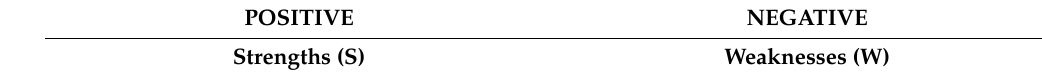
Table 1. SWOT analysis of novel food processing